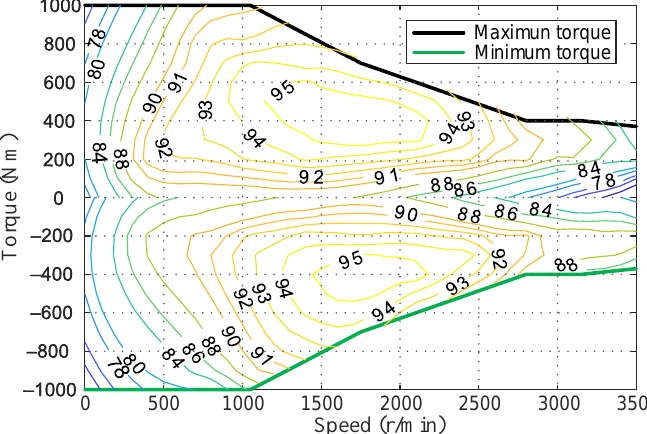
Figure 3. EM efficiency